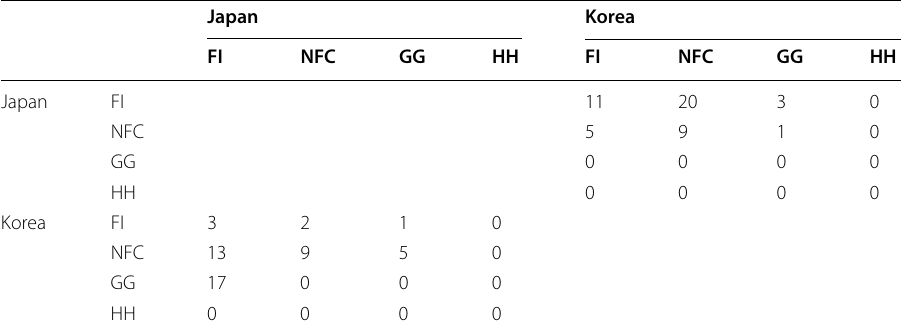
units of 1 billion USD)